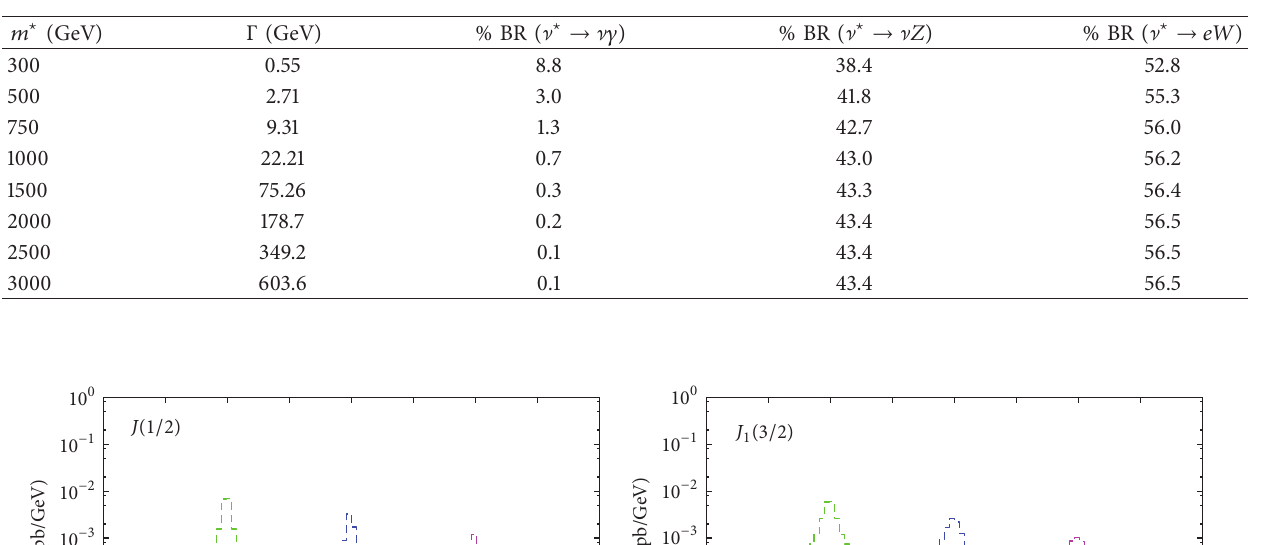
Table 3: Branching ratios and total decay width of excited spin-3/2 neutrinos with 𝐽 2 . Here it is taken as 𝑐 2𝑉 = 𝑐 2𝐴 = 0.5 and Λ = 𝑚 ⋆ .